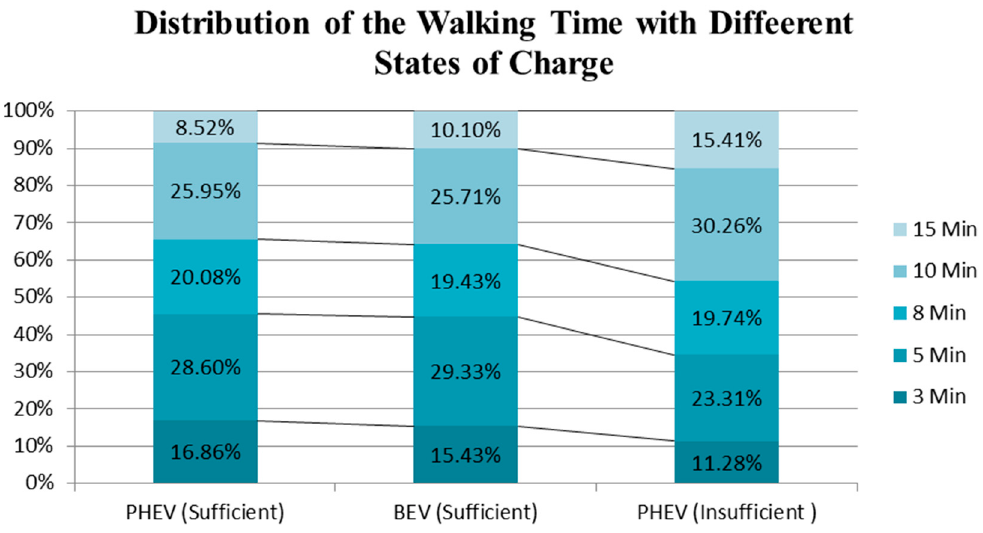
Figure 3. Distribution of the maximum acceptable walking time with different states of